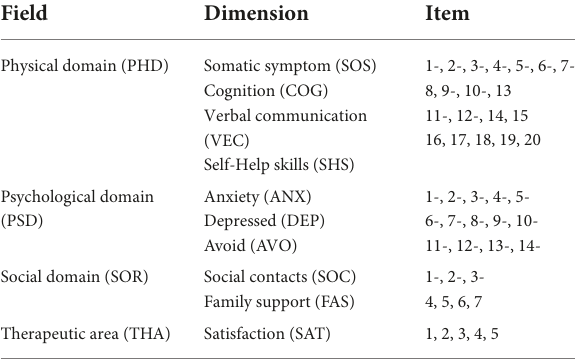
TABLE 2 Framework structure of patient-reported outcome scale for